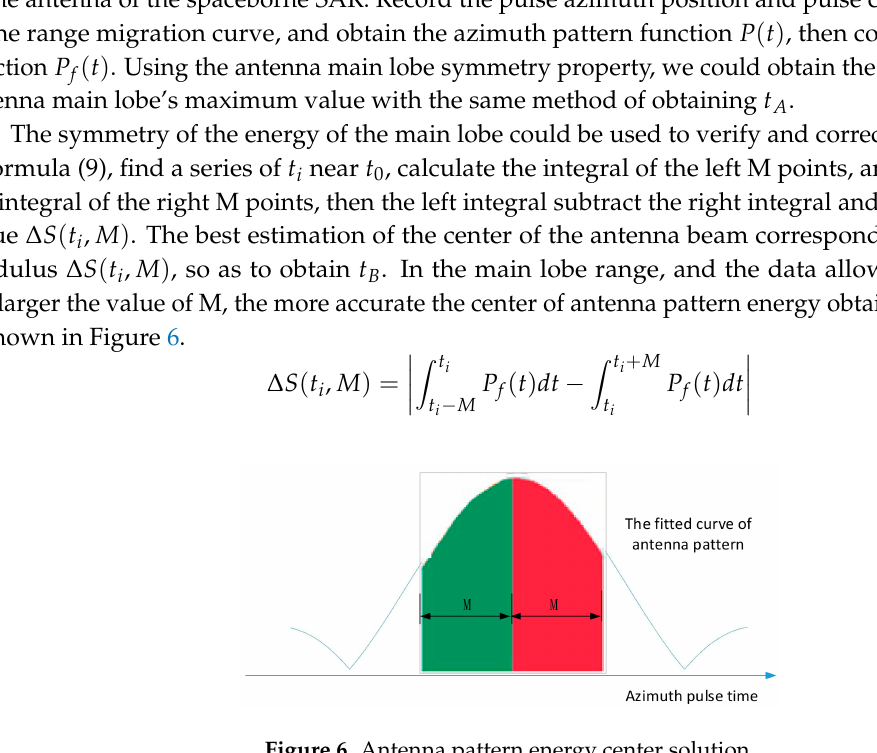
Figure 6. Antenna pattern energy center